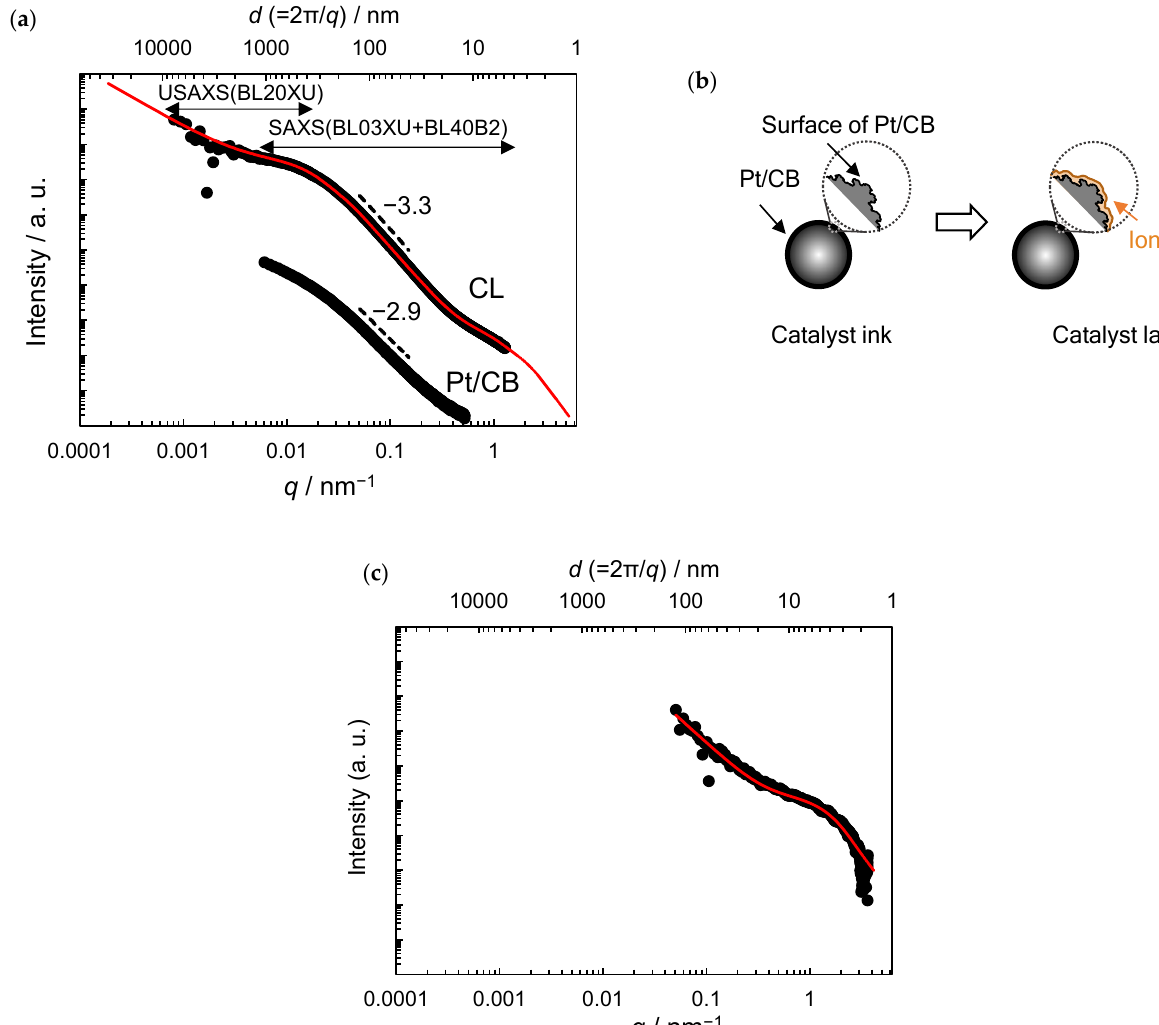
Figure 3. ( a ) The combined USAXS and SAXS intensity profiles of the CL and Pt/CB. The red solid lines in ( a ) are the fitting curve obtained using Equation (2). ( b ) Plausible model of Pt/CB surface structure. ( c ) ASAXS intensity profile of the CL calculated using Equation (1). The red solid lines in ( c ) are the fitting curve obtained using Equation (3).